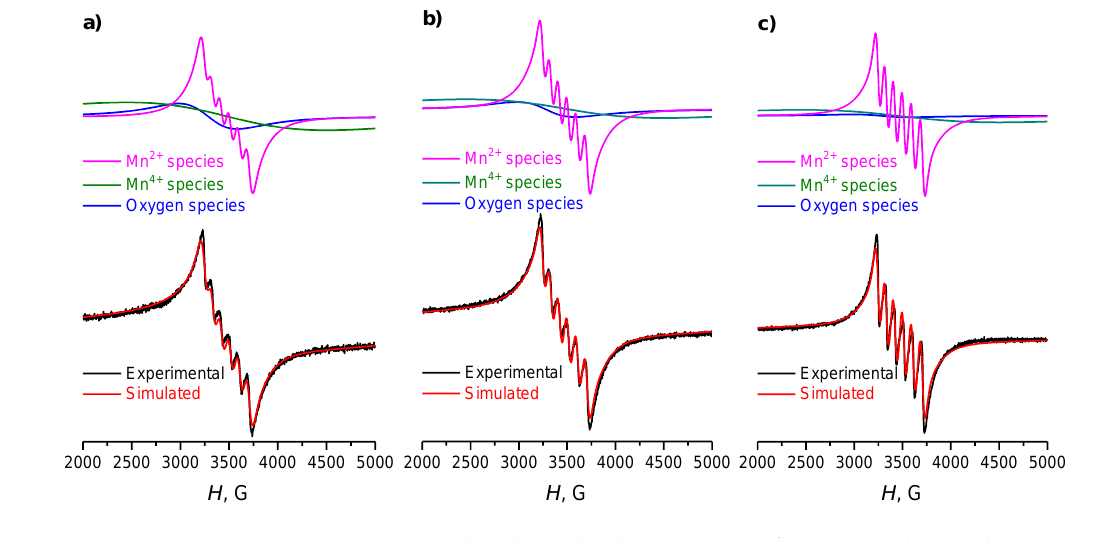
Figure 6. Experimental and simulated EPR spectra of Mn-Ce catalysts, calcined at ( a ) 500 °C, ( b ) 600 °C and ( c ) 700 °C. Different components of the spectra are presented above each simulated curve. Table 3. The components of simulated EPR spectra and their contribution to overall spectrum.